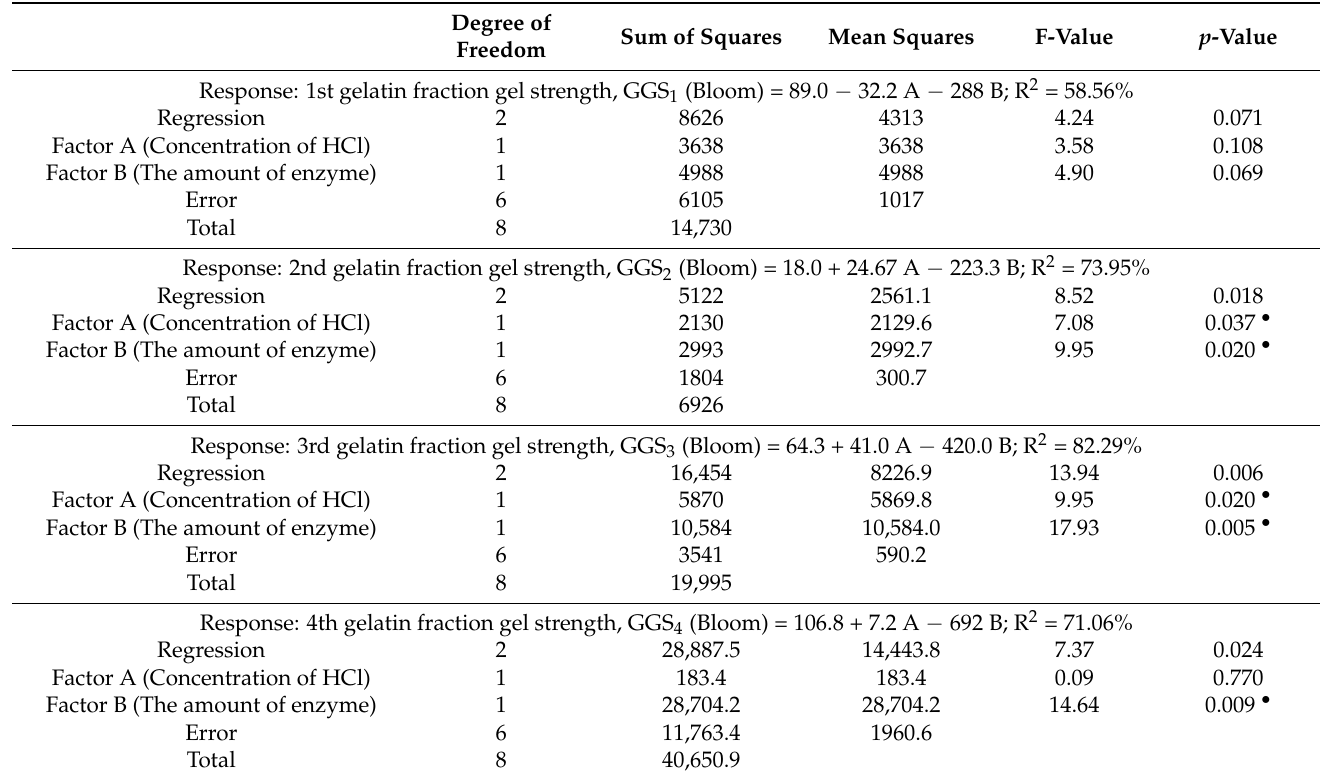
Table 4. Analysis of variance of the experimental design for gelatin gel